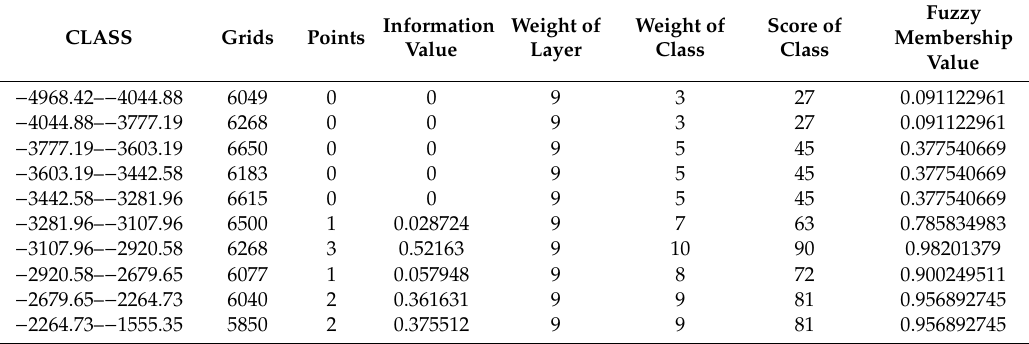
Table 2. Fuzzy membership value of